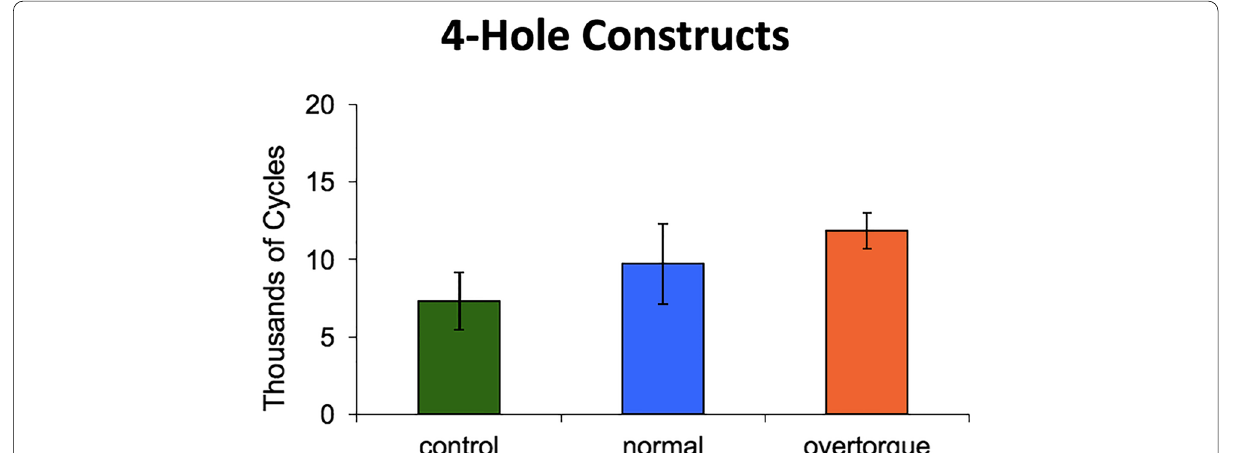
Fig. 5 Average cycles to failure for four-hole constructs (mean standard deviation). Significantly fewer cycles were required to failure in the ± control group versus the normal and overtorque group. A significant difference was also found between the normal and overtorque groups